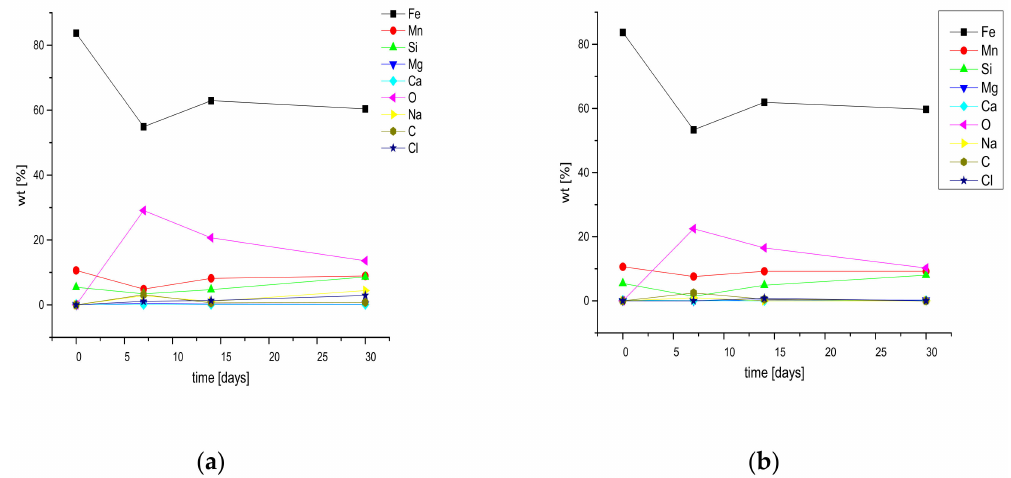
Figure 3. Chemical elements (Fe, Mn, Si, Mg, Ca, O, Na, C, and Cl) mass % variation EDX determinations; ( a ) after immersion and ( b ) after immersion and sonication cleaning.